Question: Produce a descriptive caption suitable for publication.
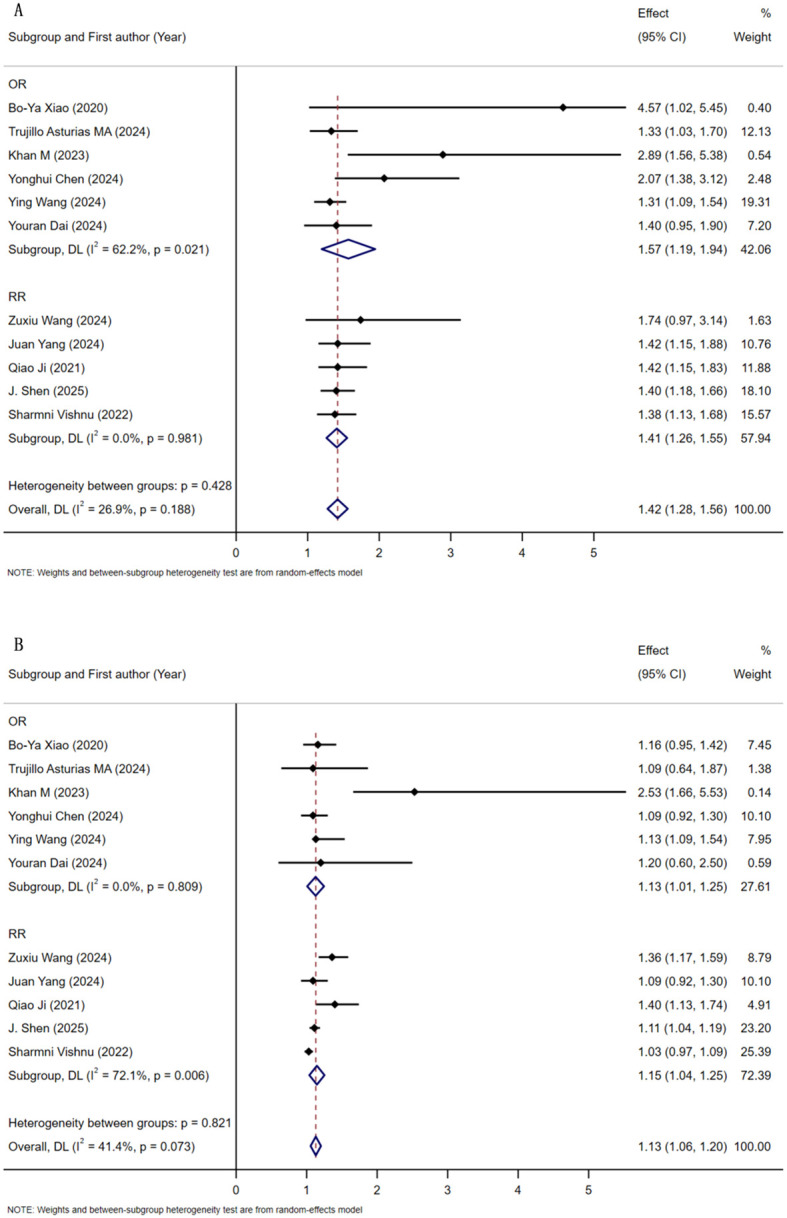
Answer: Forest plots of treatment-related AEs. (A) All-grade AEs; (B) Grade ≥ 3 AEs.